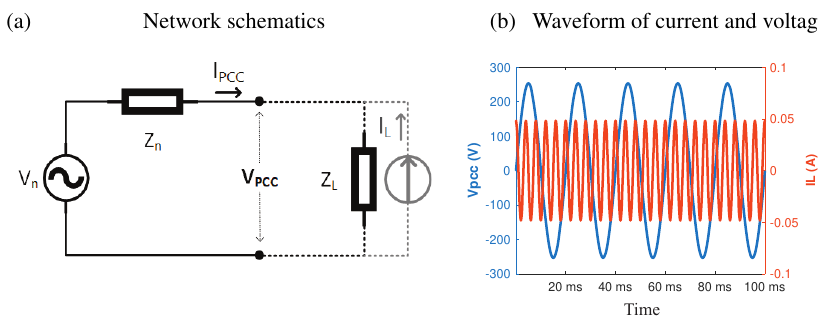
Fig. 1. Current and voltage waveforms at the